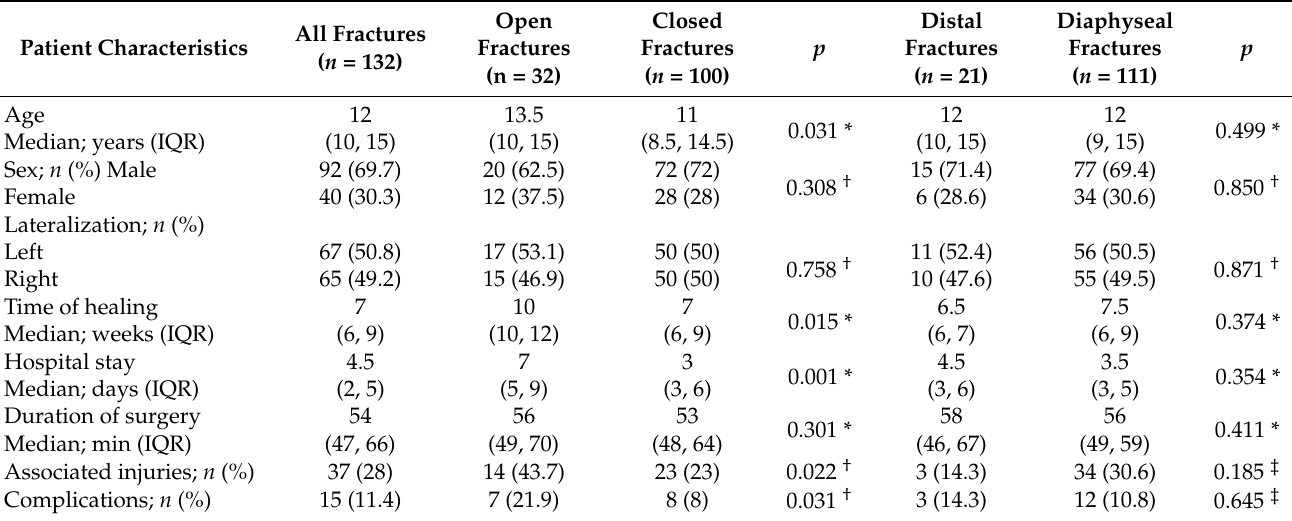
Table 1. Demographic data of the patients and clinical characteristics of fractures.